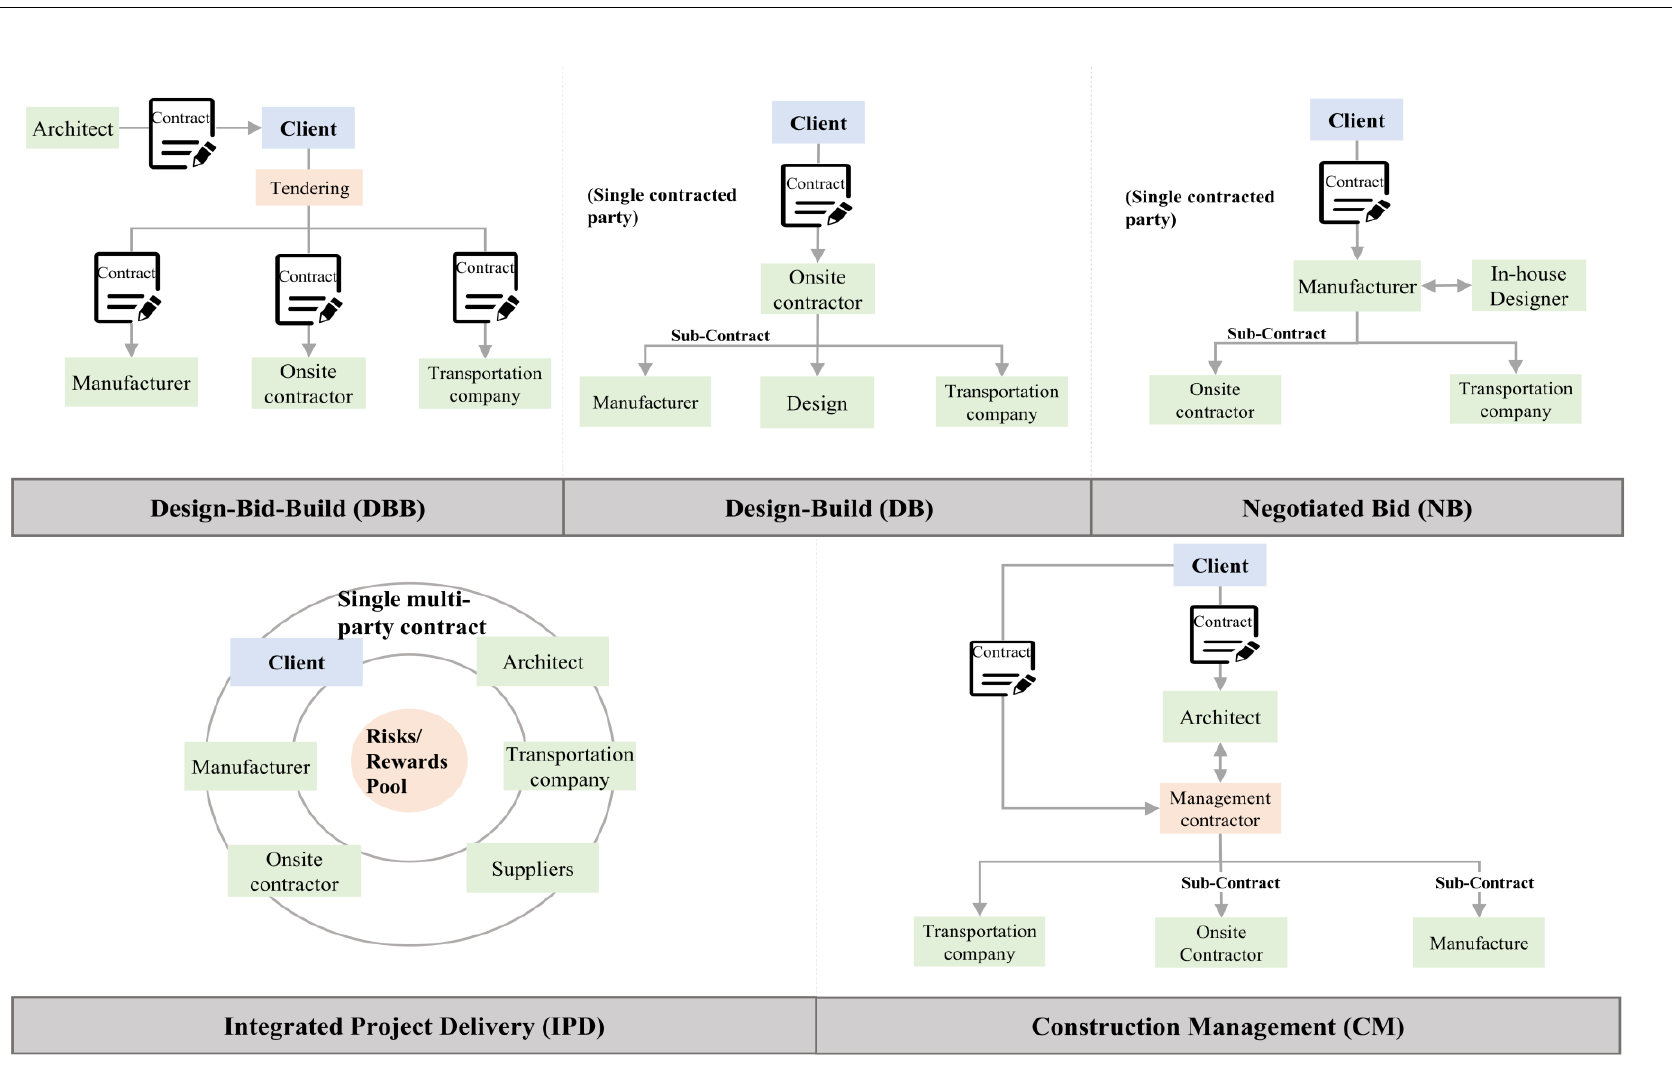
Figure 1. The arrangements of different procurement methods in OSC projects.